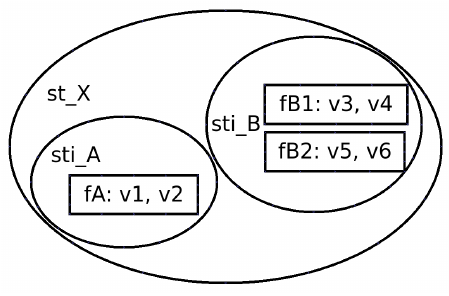
Figure 13: An example speciesFeatureType to illustrate the usage of ListOfSpeciesFeatures , SubListOfSpecies- Features and the SpeciesFeature